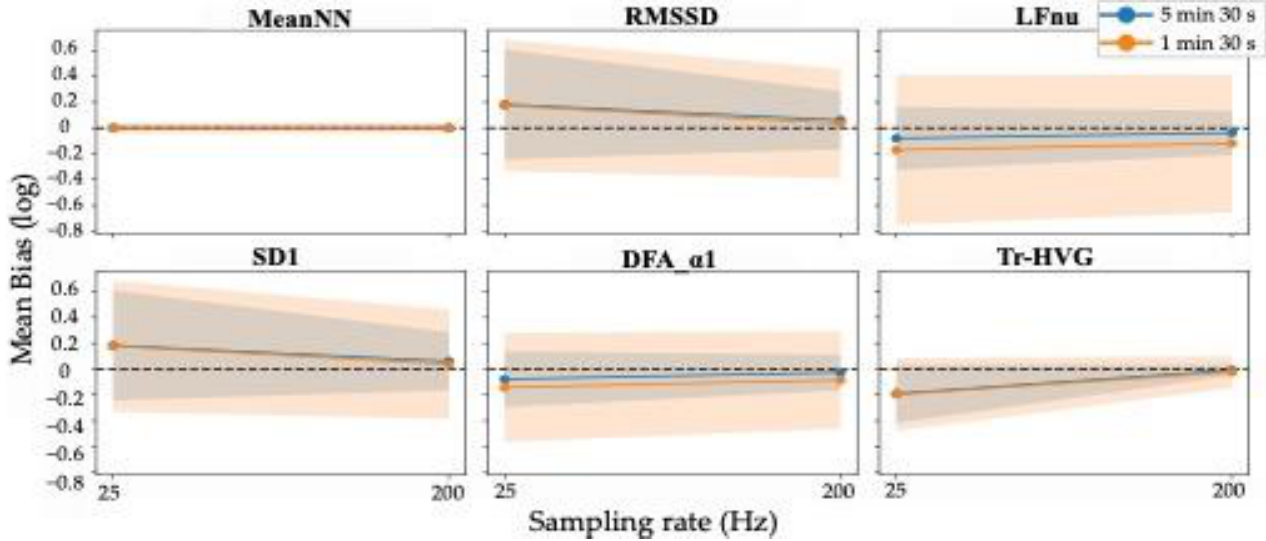
Figure 5. Mean bias changes and 95% LoA of a selection of some HRV features for both durations of 5 min 30 s and 1 min 30 s with increasing the sampling rate from 25 Hz to 200 Hz. Blue and orange lines and shadows indicate the mean of observed bias and the 95% LoA for 5 min 30 s and 1 min 30 s, respectively. The dotted black line is the line of equality with null bias.